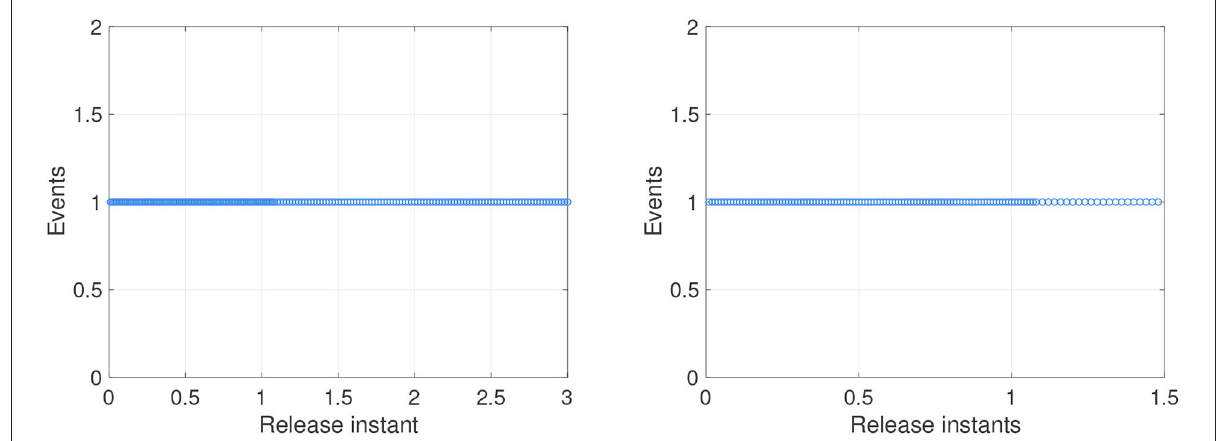
FIGURE10 The events with self-triggered control. (A) Instants for synchronization ε ( t )